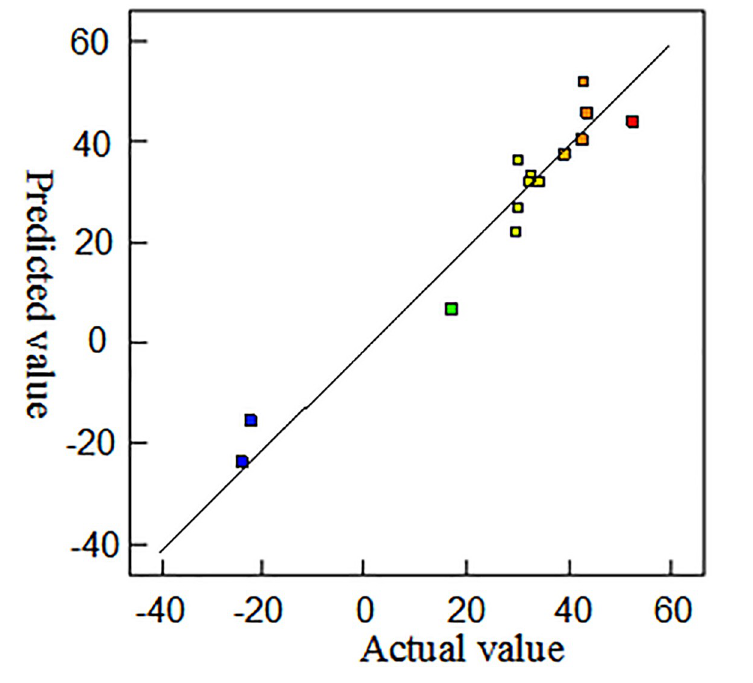
Fig 11. Predicted value and actual distribution